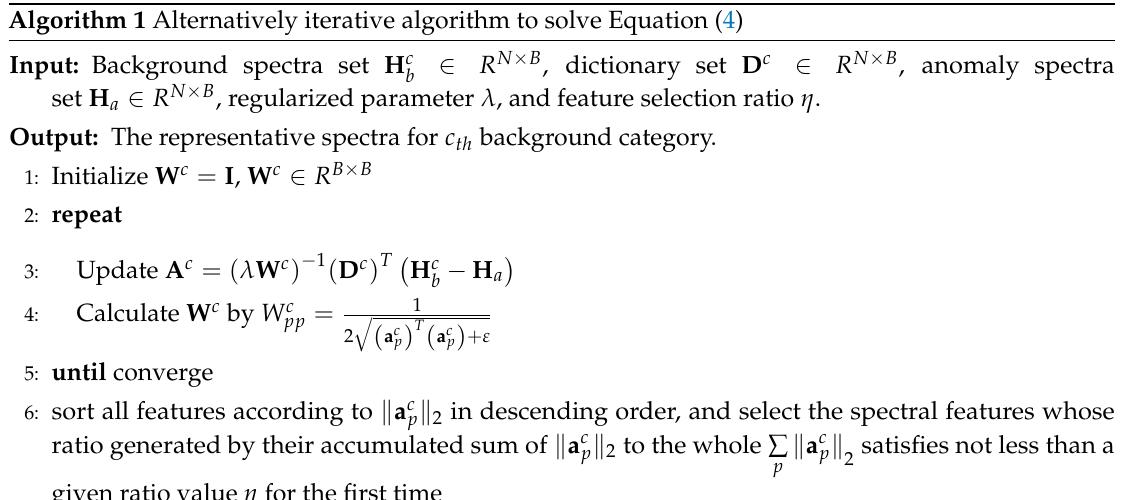
Algorithm 1 Alternatively iterative algorithm to solve Equation